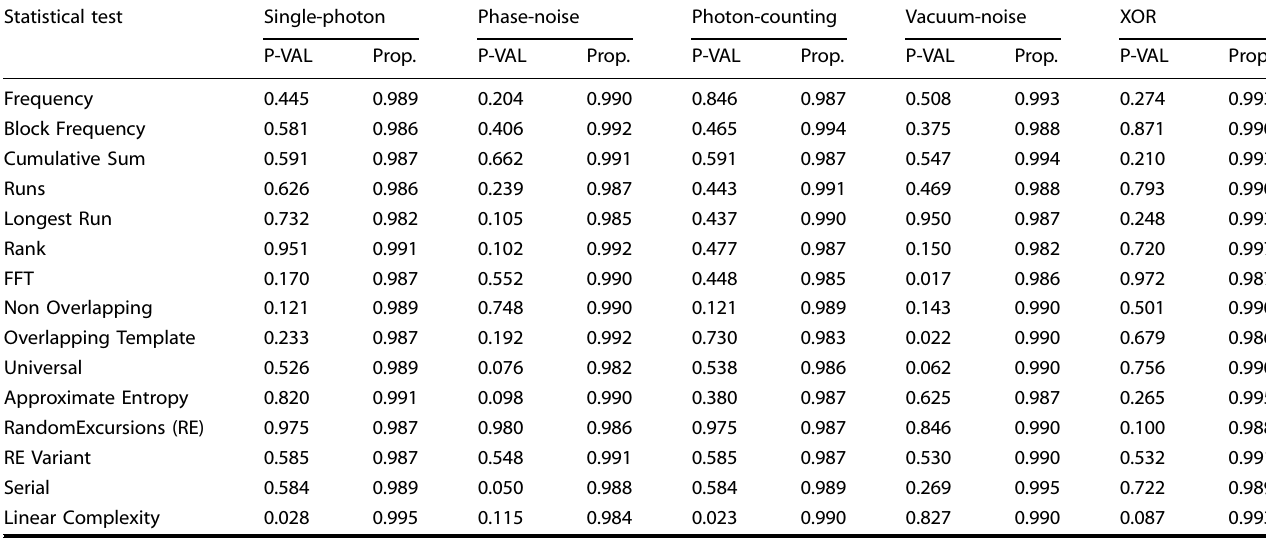
Table 2. Random numbers from QRNG sources pass the NIST randomness